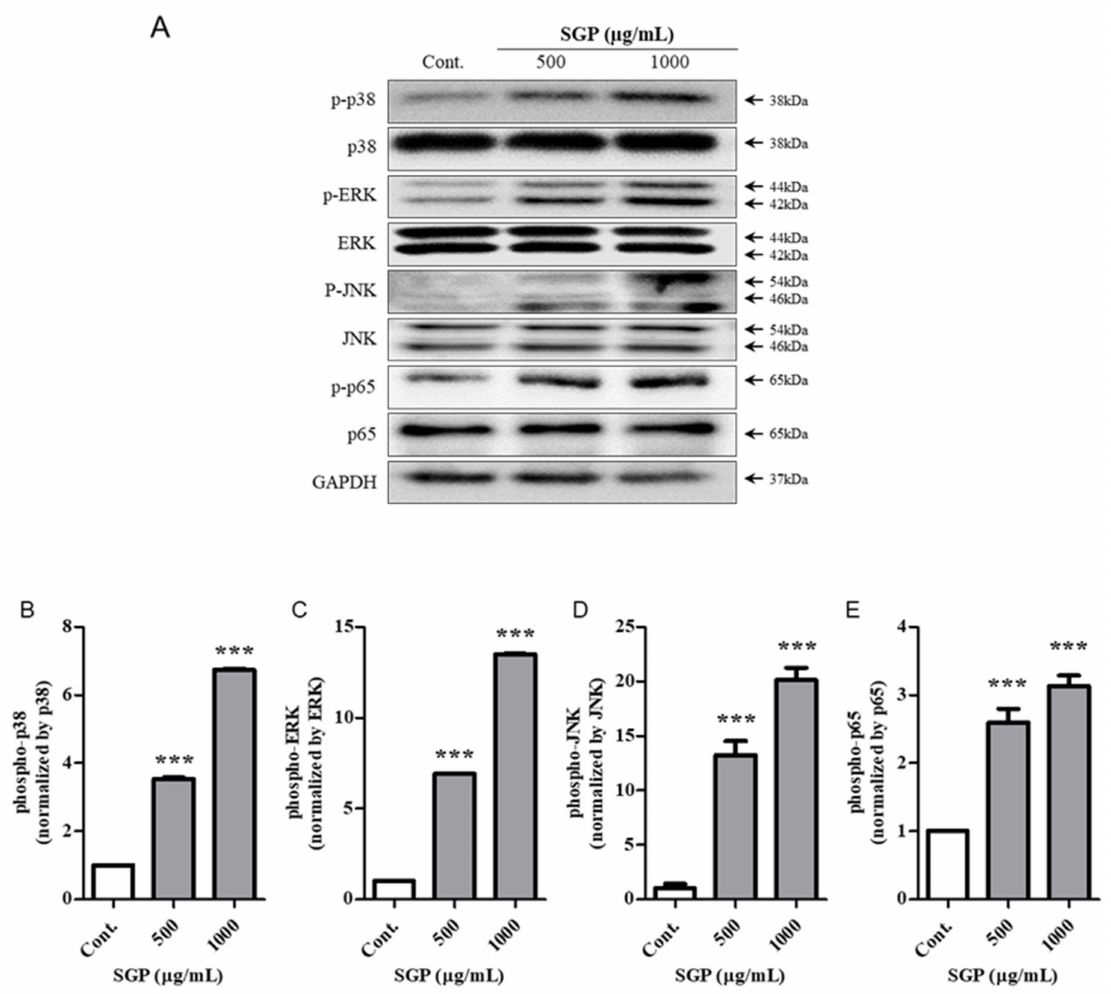
Figure 6. Phosphorylation of MAPKs and NF- κ B through SGP stimulation of RAW264.7 cells. RAW264.7 cells were stimulated with SGP (500 and 1000 µ g/mL) for 30 min. Phosphorylation and total protein detection of ERK, JNK, p38, and p65 from cell lysates prepared from SGP-stimulated RAW264.7 cells were calculated by phosphor-specific or total protein antibodies. Phosphorylation or total protein levels of ERK, JNK, p38, and p65 ( A ). Quantification of p-ERK/ERK, p-JNK/JNK, p-p38/p38, and p-p65/p65 intensity ( B – E ). Shown are the means ± SD of triplicate experiments. *** p < 0.0001, compared to the